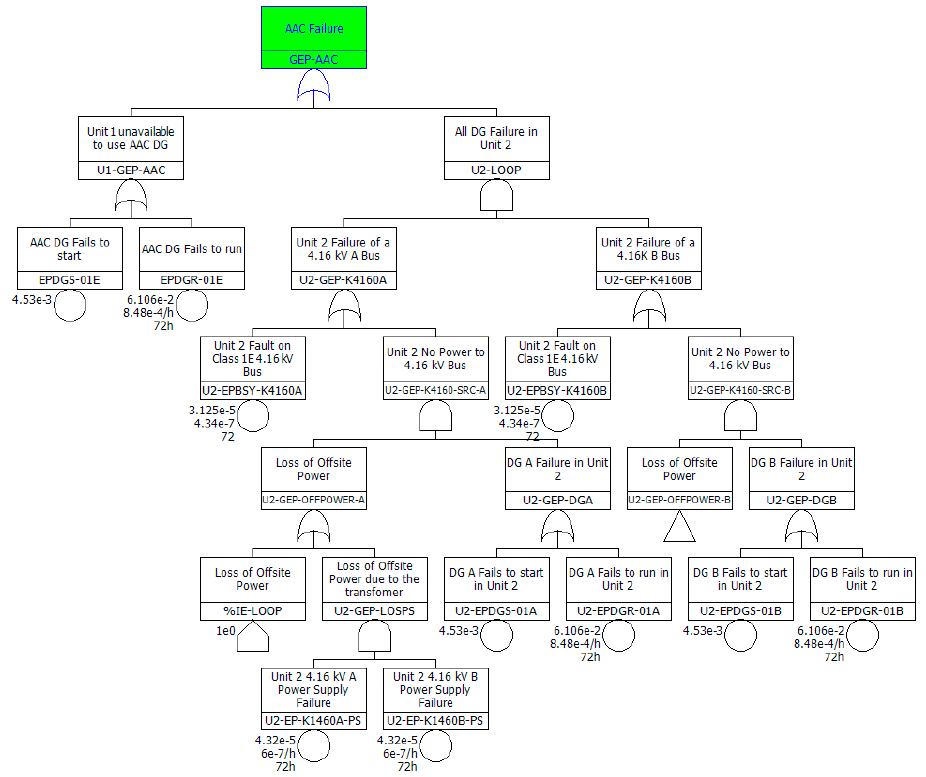
Figure 3. The SFT with the failure of the power supply to Unit 1 in the dual-unit SBO as the top event.